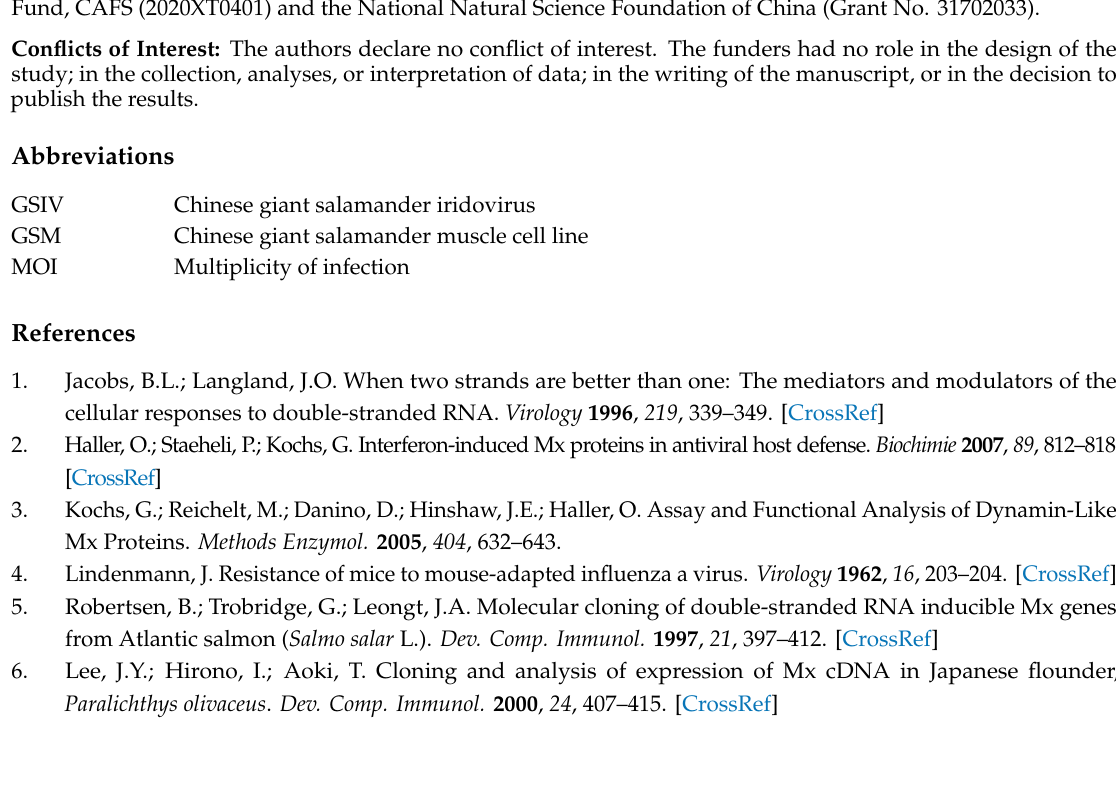
s1. Figure S1. Expression of AdMx in GSM cells by Western blot analysis. Western blot was performed on equal amounts of protein harvested from Normal GSM cells, pEGFP-N1 transfected GSM cells and pEGFP-N1-AdMx transfected GSM cells at 48 h post transfection using anti-EGFP monoclonal antibody. β -actin was used as a loading